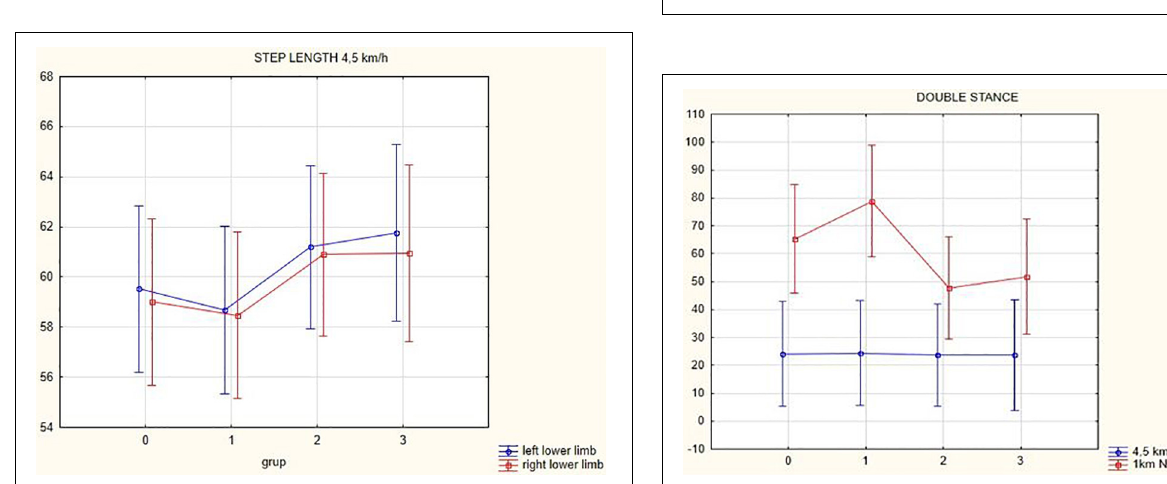
FIGURE 3 | Double stance phase duration in the gait at a speed 4.5 km/h and in the narrow-based gait at a speed of 1